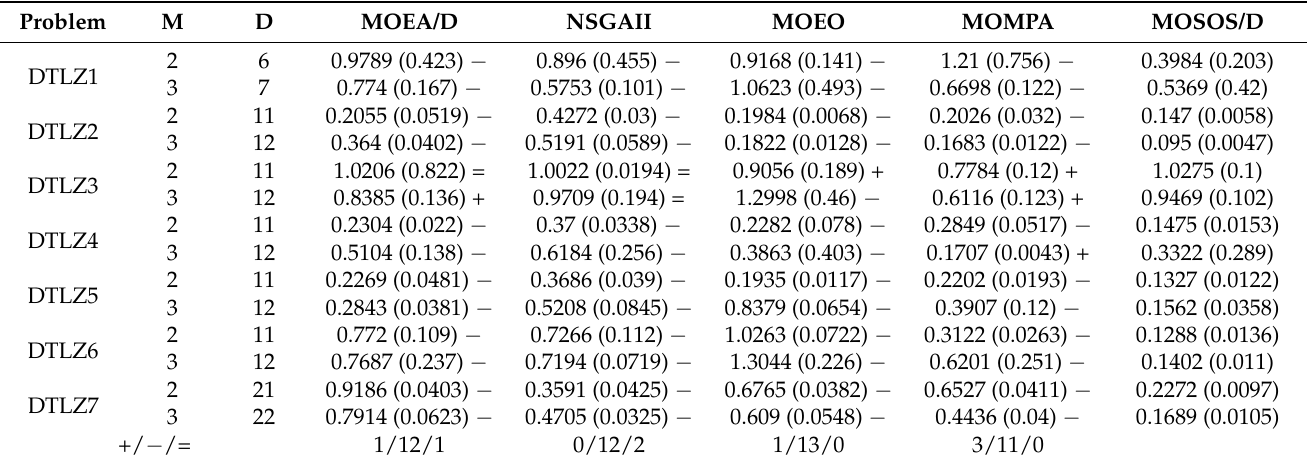
Table 3. The SD (coverage of non-dominated solutions) metric